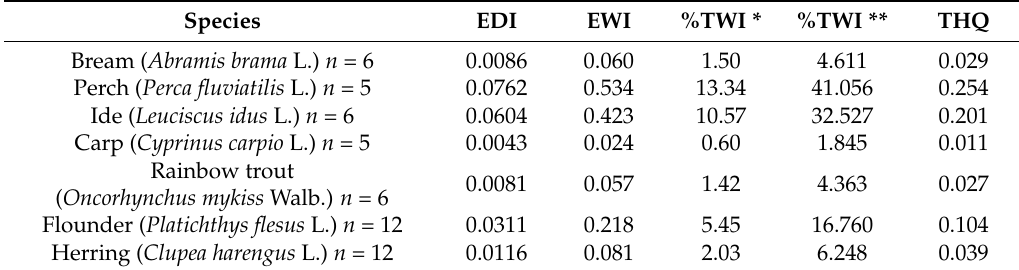
Table 4. The Hazard Quotient calculated for mercury content in the muscle tissue of